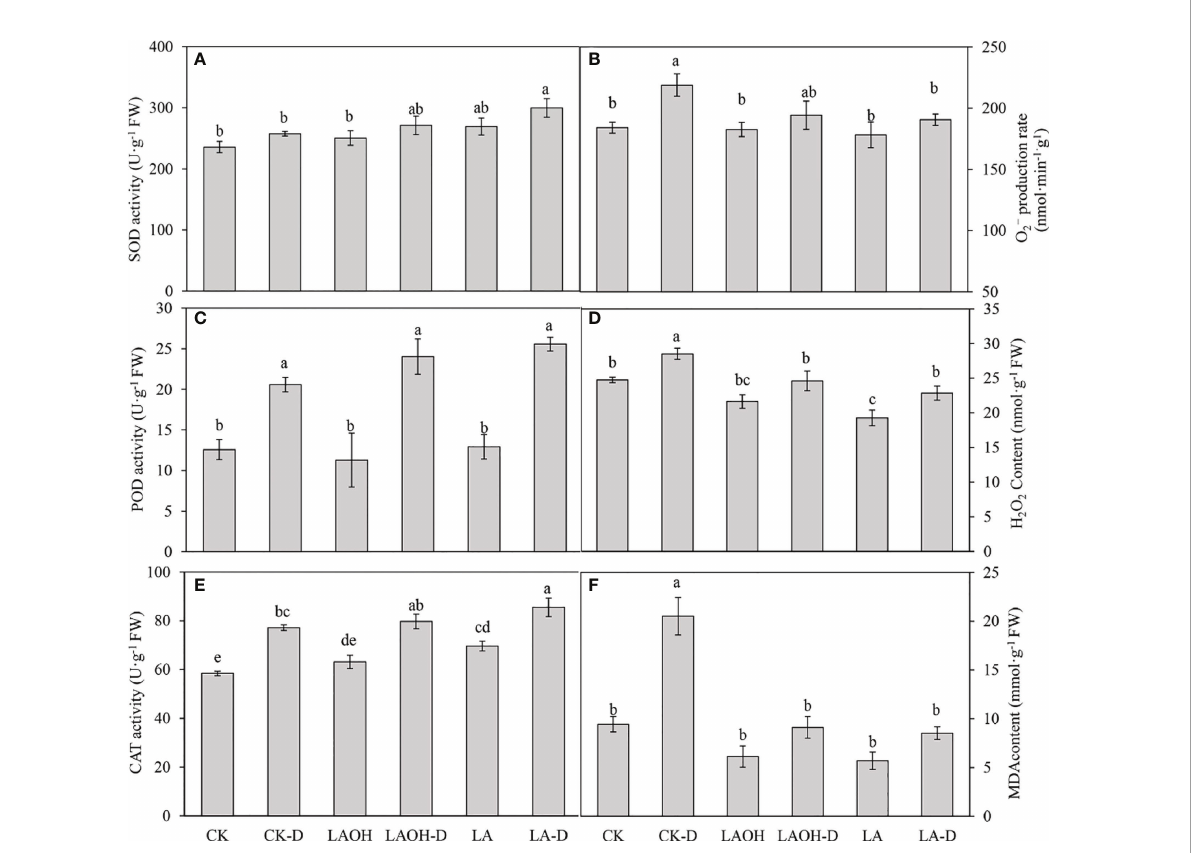
FIGURE 9 Effects of LA and LA-OH on antioxidant enzyme activity and MDA content of P. persica leaves under drought stress (A) SOD; (B) O 2 − production rate; (C) POD; (D) H 2 O 2 content; (E) CAT; (F) MDA content). Data are mean ± SD (n = 3). Duncan ’ s test and ANOVA were used. Signi fi cant differences (P<0.05) are indicated by different